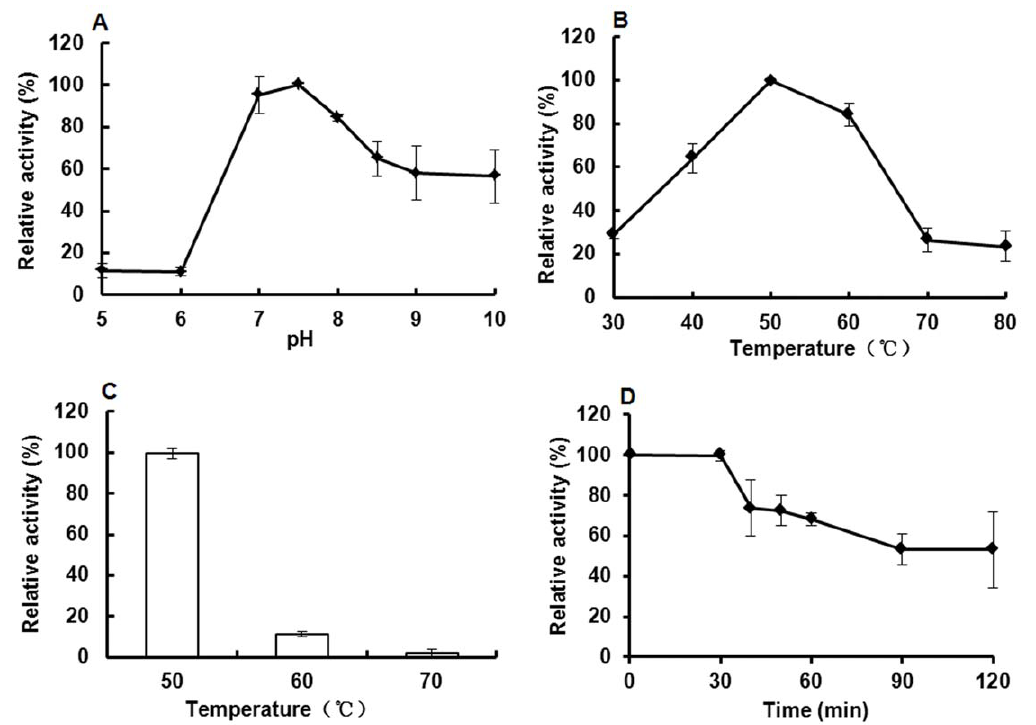
Figure 8. Enzymatic properties of the purified keratinase. A: The optimum pH of keratinase; B: The optimum temperature of keratinase; C: The keratinolytic temperature stability; D: The keratinolytic thermostability. The maximum value was taken as 100%.